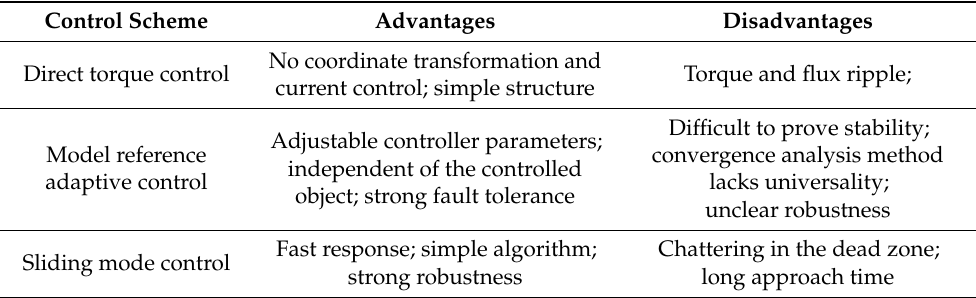
Table 1. Advantages and disadvantages of different control schemes for